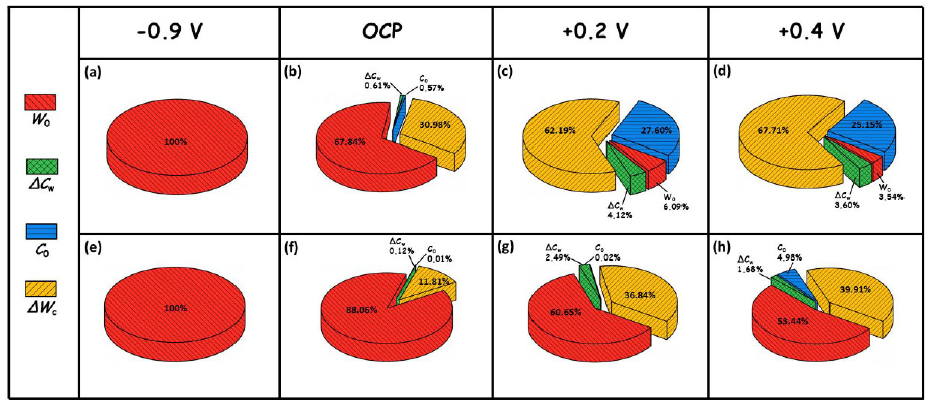
Fig. 12 Contribution of the various degrading components to the total material loss of (a–d) AISI 1045 and (e–h) AISI 2205 at different applied potentials after sliding under 80 N load and 80 rpm